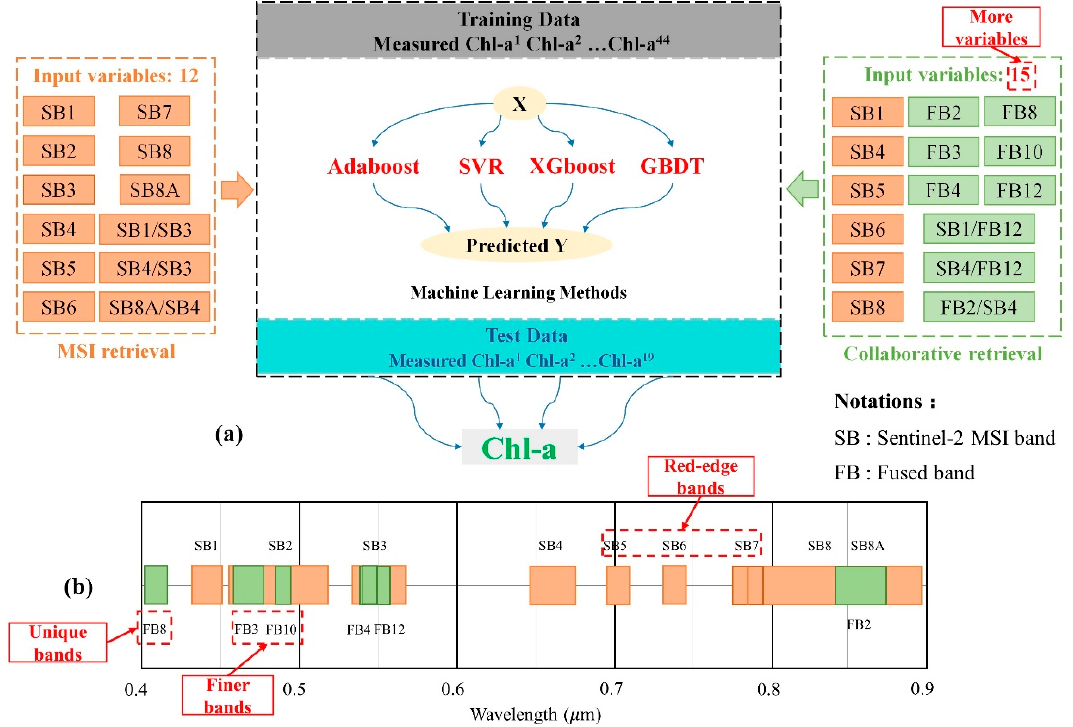
Figure 5. ( a ) Schematic block diagram depicting the brief steps of four machine learning methods to obtain Chl-a retrieval from input variables, including MSI and collaborative retrieval. ( b ) The bands involved in the MSI and collaborative